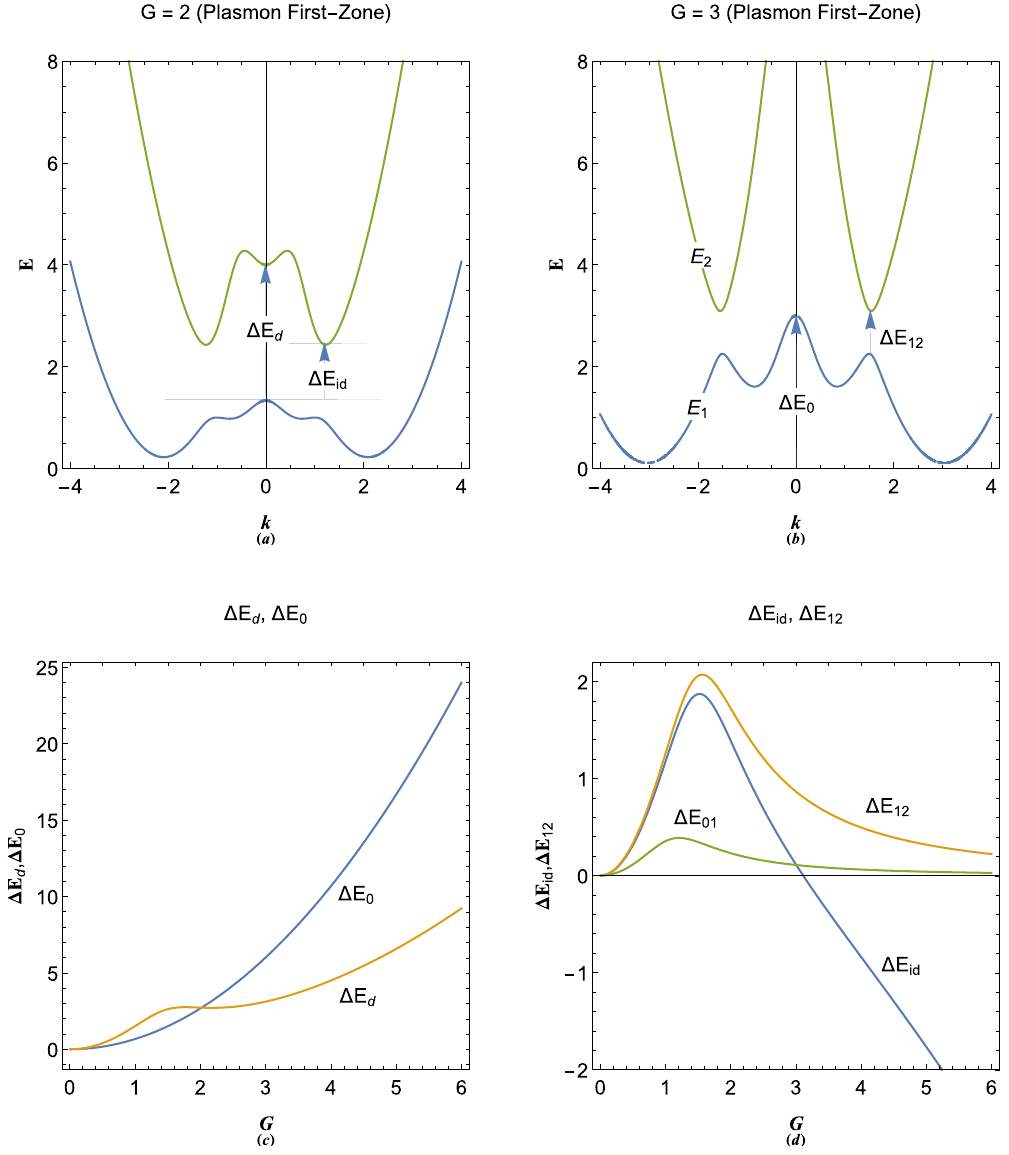
2 in three-zone ( N 3 ) empty- = = 2 π/ a , =